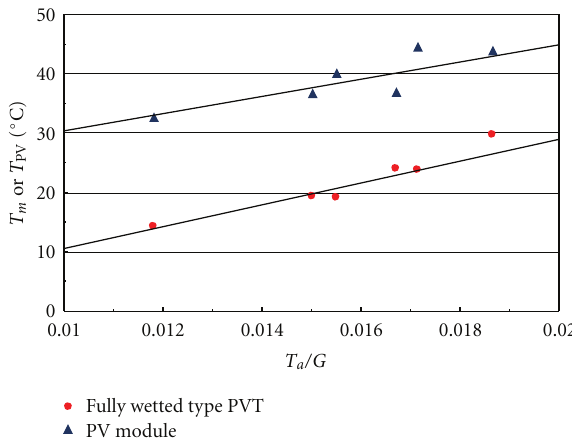
Figure 9: Mean temperature of the fully wetted PVT collector and PV temperature of as a function of the ambient temperature and solar radiation.